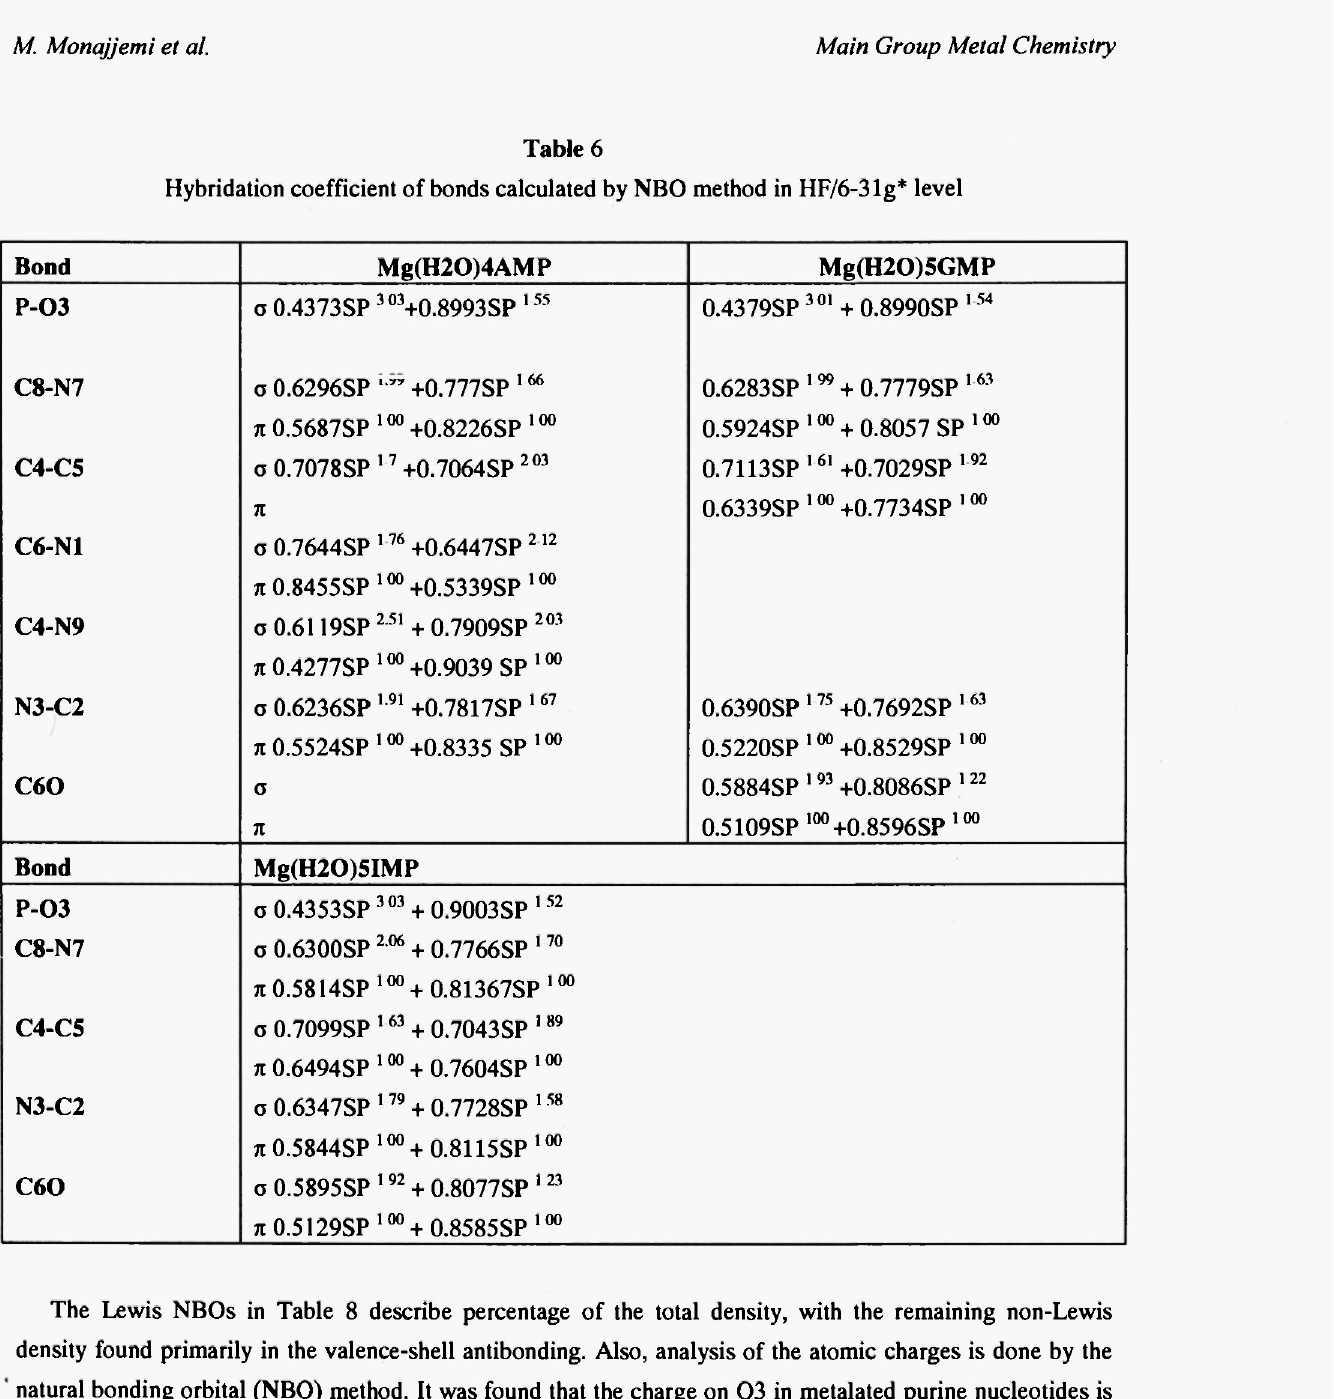
Hybridation coefficient of bonds calculated by NBO method in HF/6-31g*